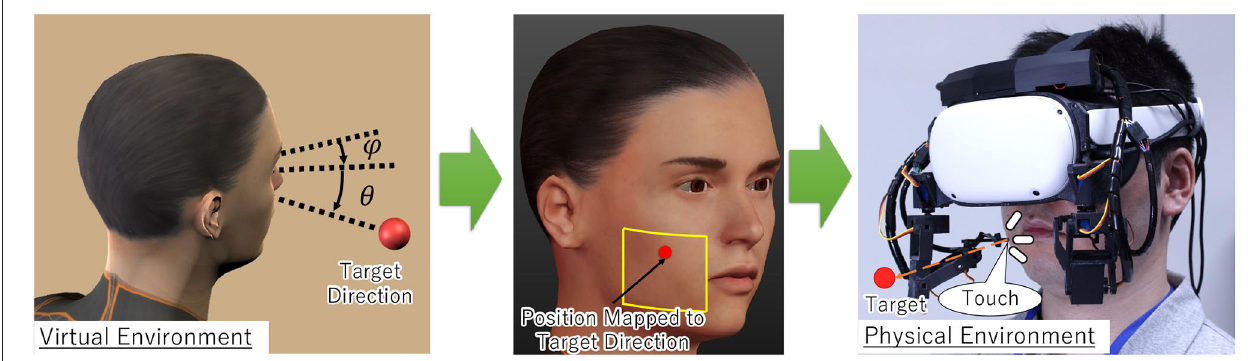
FIGURE 1 | Spatial directional guidance using cheek haptic stimulation. (Left) The direction of a target (red sphere) in a virtual space is represented as the azimuthal angle ϕ and the elevational angle θ in a spherical coordinate. (Center) The azimuthal and elevational angles ( θ , ϕ ) are mapped to a point on a cheek surface. (Right) A robot arm touches the point on the cheek to present target directional